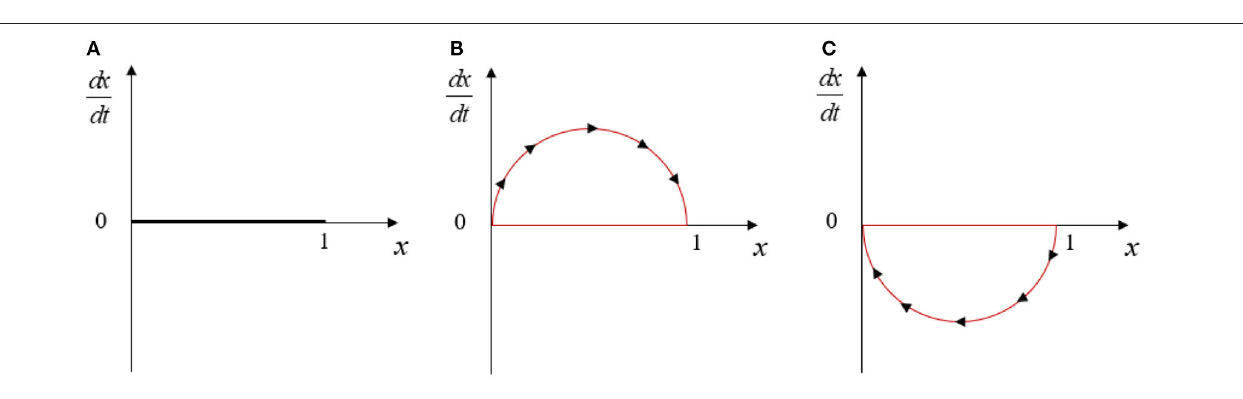
, (B) x ∗ < − γ W 2 − ( β − 1) S 2 − C E 2 , and (C) x ∗ > − γ W 2 − ( β − 1) S 2 − C E 2 (1 − γ ) W 2 + C E 1 − C E 2 (1 − γ ) W 2 + C E 1 − C E 2 (1 − γ ) W 2 + C E 1 − C E 2